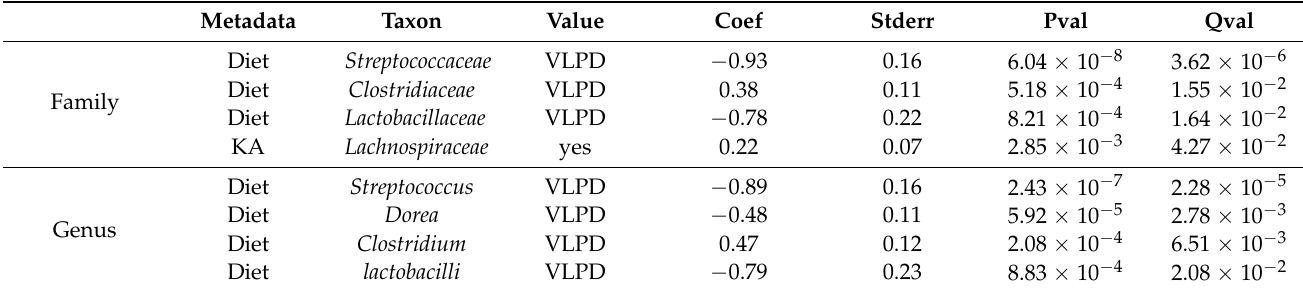
Table 4. Multivariable and significant associations ( p < 0.05 and q < 0.05) between bacterial abundances (16rDNA gene amplicon sequences) and dietary features. Both Mediterranean diets (MD and MD + KA) were grouped together and compared with the VLPD. Both diets supplemented with ketoanalogs (MD + KA and VLPD) were grouped together in “yes” and compared with the unsupplemented MD (“no”). The column “value” describes to which feature are related the data reported into the same row.